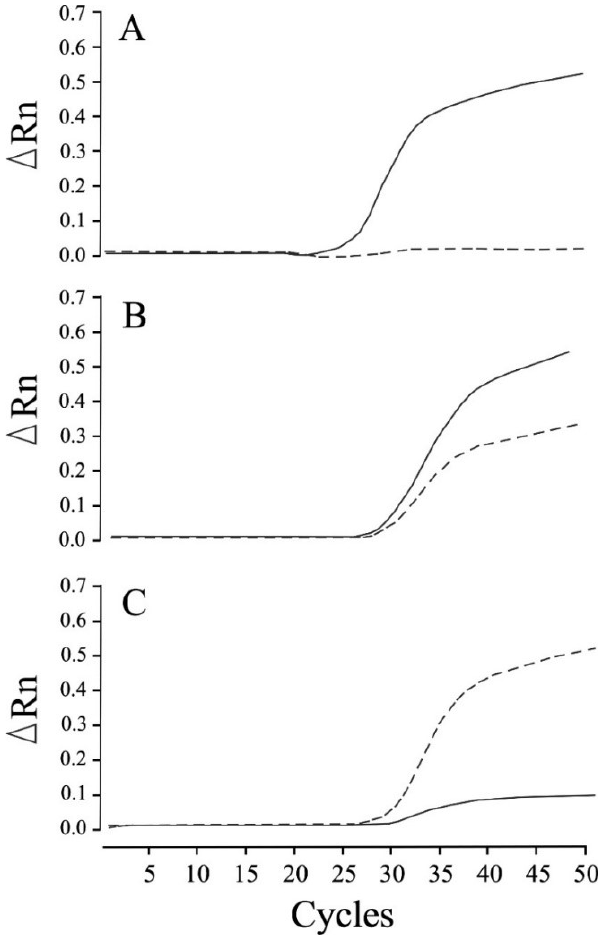
Figure 1. Real-time PCR amplification plots of wild-type and mutant alleles for neuronal ceroid lipofuscinosis in Chihuahuas. Amplification was plotted as fluorescence intensity (ΔRn values) against the cycle number. ΔRn values represent the reporter dye signal normalized to the internal reference dye and corrected for the baseline signal established in the initial few PCR cycles. The three amplification plots show the homozygous wild-type ( A ), heterozygous carrier ( B ), and homozygous mutant (affected) ( C ) genotypes. The solid and dotted lines indicate amplification in the presence of wild-type and mutant alleles, respectively.